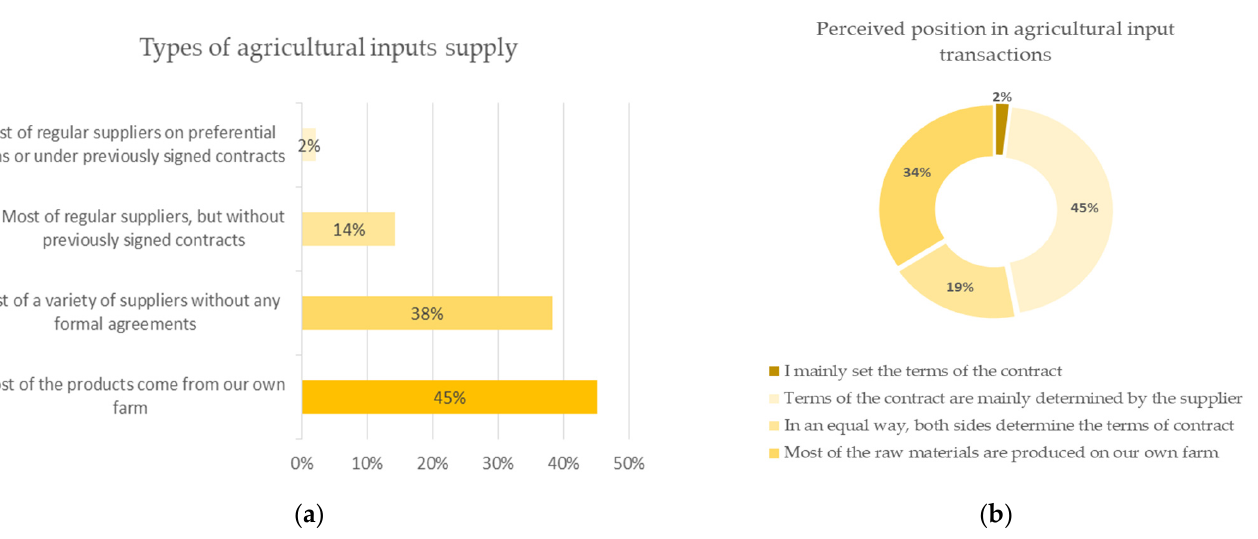
Figure 3. Types of agricultural inputs supply ( a ) and positioning in agricultural input transactions ( b ) of the small-scale farms in Lithuania (N = 1002).